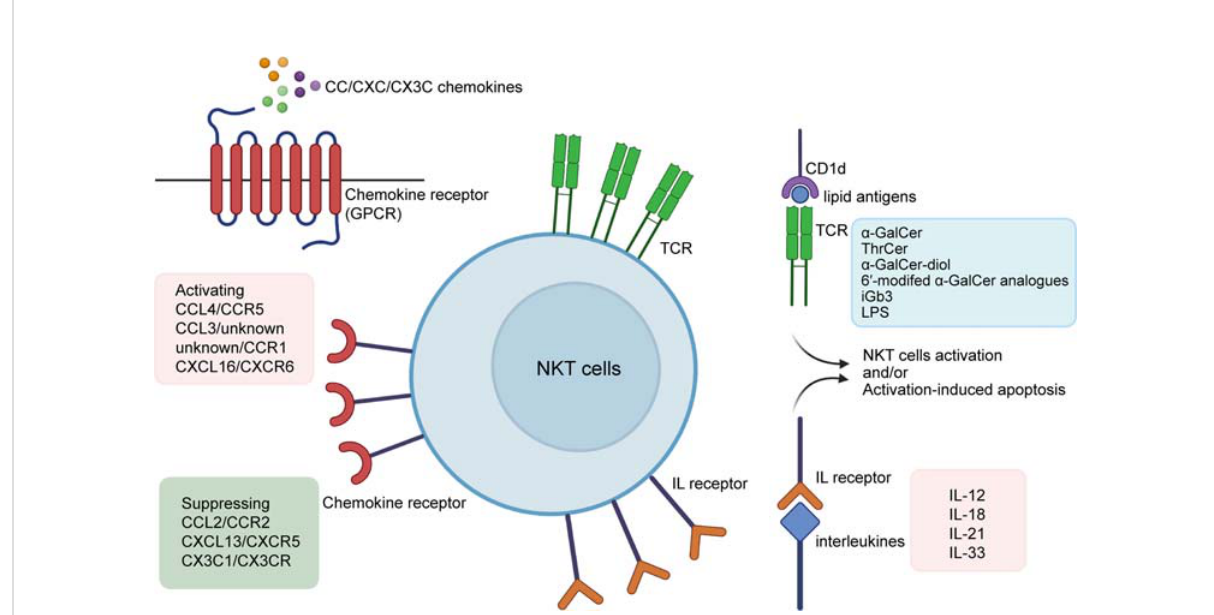
FIGURE 1 Activators of NKT cells. a -Galcer and some of its analogues (e.g.ThrCer, a -GalCer-diol, 6 ′ -modifed a -GalCer analogues), iGb3, and LPS are among lipid antigens proven to activate NKT cells via the CD1d-dependent pathway; interleukins such as IL-2, IL-12, IL-15, IL-18, IL-21, and IL- 33 promote NKT cells by binding directly to their interleukin receptors; CC/CXC/CX3C chemokines are associated with the recruitment and proliferation of NKT cells, with non-exclusive matches with their receptors that come in the form of GPCRs. Also, a -Galcer and some interleukins may also lead to activation-induced apoptosis of NKT cells. a -GalCer, a -galactosylceramide; ThrCer, threitolceramide; iGb3, isoglobotrihexosylceramide; LPS, lipopolysaccharide; IL,